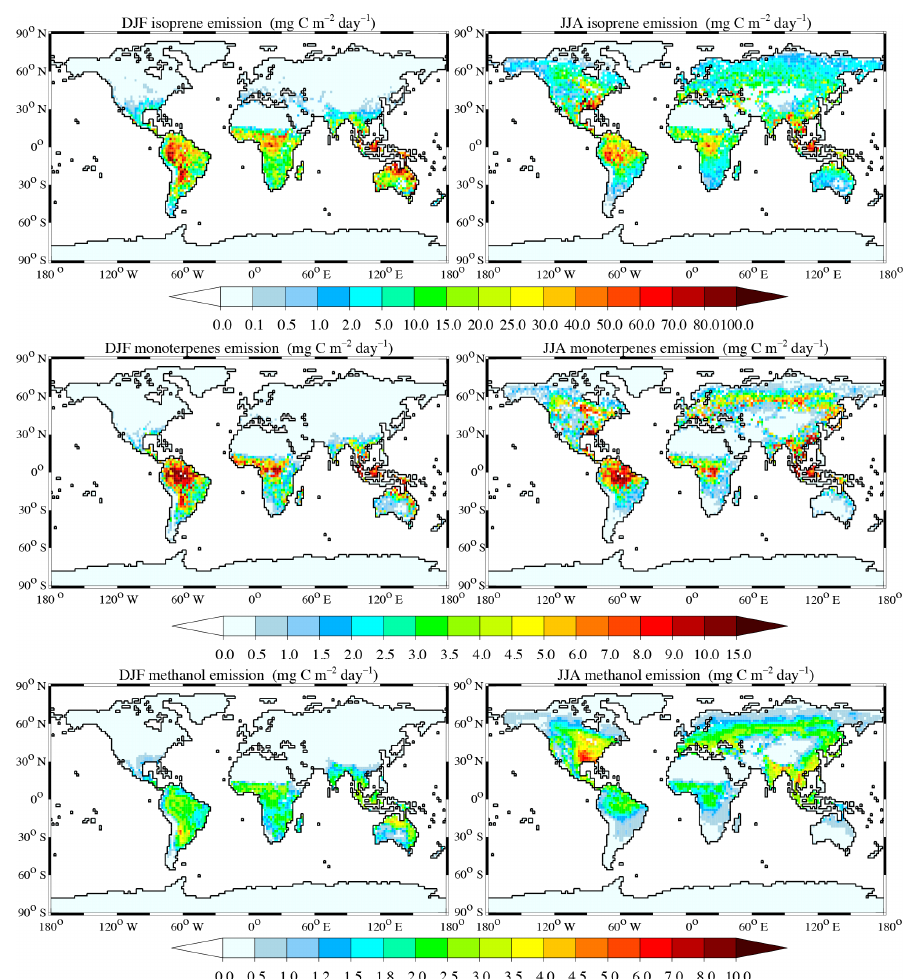
Figure 3. Spatial distribution of global December–January–February (DJF) and June–July–August (JJA) emissions (mgCm − 2 day − 1 ) for isoprene, the sum of monoterpenes, and methanol averaged over the 12 years (2000–2012) of the reference